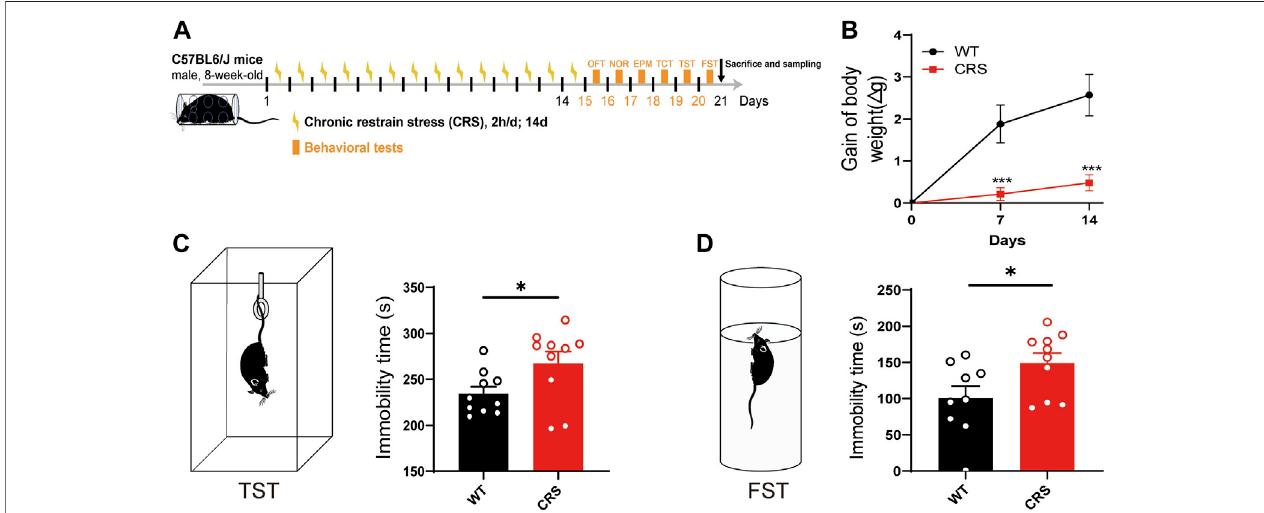
FIGURE1 | CRSmice showed adepressive-like phenotype. Schematicdiagram showing experimental procedures ofCRS mouse model (A) . Compared withWT controls,theweightofmicerelativedecreasedafter7or14 daysofCRS(WT: n =10;CRS: n =10) (B) .Inthetailsuspensionexperiment,theimmobilitytimeofCRSmice was signi fi cantly increased (WT: n = 10; CRS: n = 10) (C) . In FST, the immobility time of CRS mice was also increased (WT: n = 9; CRS: n = 10) (D) . The data were analyzed by unpaired t -test. *p < 0.05, ***p < 0.001. CRS, chronic restraint stress; WT, wild type; FST, forced swimming